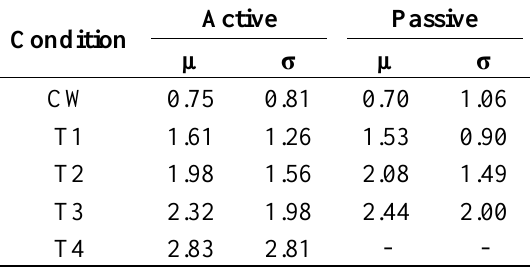
Table 7. Aeolus: accuracy evaluation (mean distance µ in mm and standard deviation